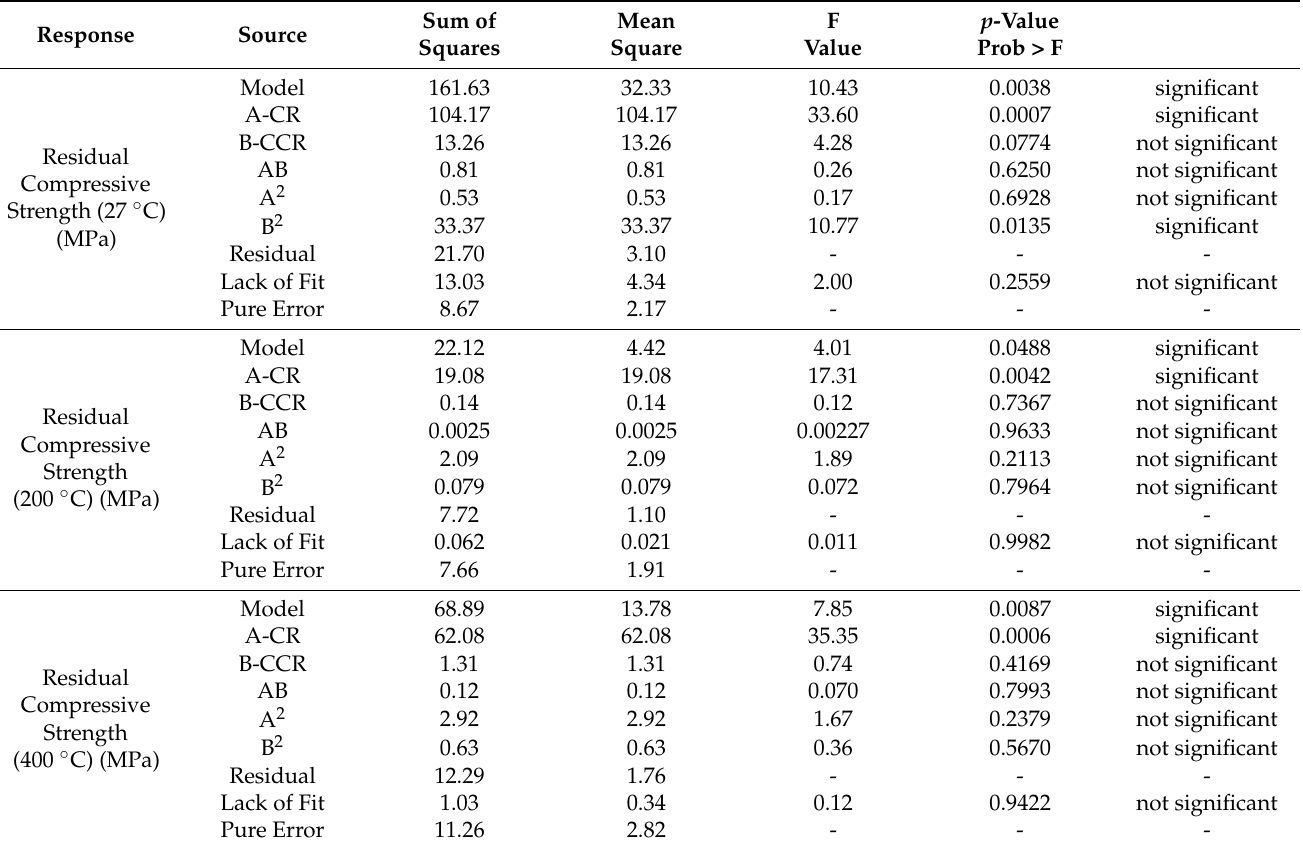
Table 8. An R 2 value of 1 (unity) implied a perfectly fitted model, while a lower R 2 value implied a model not well fitted. All of the developed models have a reasonably high degree of correlations (R 2 > 0.7), which implies that for all of the models, only less than 30% of the experimental data could not be explained by the models. The R 2 values of 0.882, 0.741, and 0.849 for residual compressive strengths models at 27 ◦ C, 200 ◦ C, and 400 ◦ C, respectively, implied that all of the experimental data were fitted and explained by the model except 11.8%, 25.9%, and 15.1% for residual compressive strengths at 27 ◦ C, 200 ◦ C, and 400 ◦ C models, respectively. The adjusted and predicted R 2 values were further used to check the adequacy and correlation of the models. For a good and well-fitted model, the